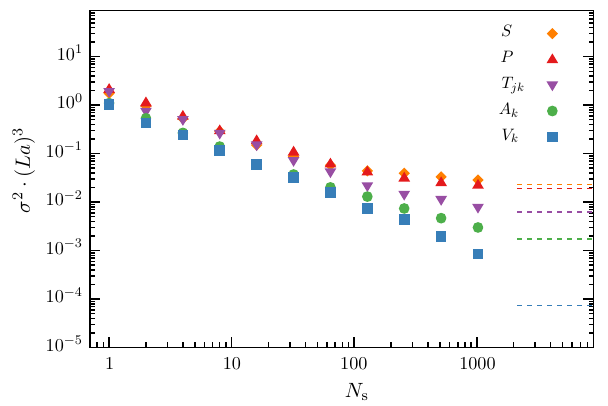
Fig. 1 Variances of the standard random noise estimators defined in Eq. (3.9) as a function of the number of random sources N s for the ensemble F7. The symbols S , P , T jk , A k and V k stand for (cid:6) = I , γ 5 , σ γ γ γ jk , k k respectively. The dashed lines indicate the gauge-noise 5 and contributions to the variances computed in Sect. 6